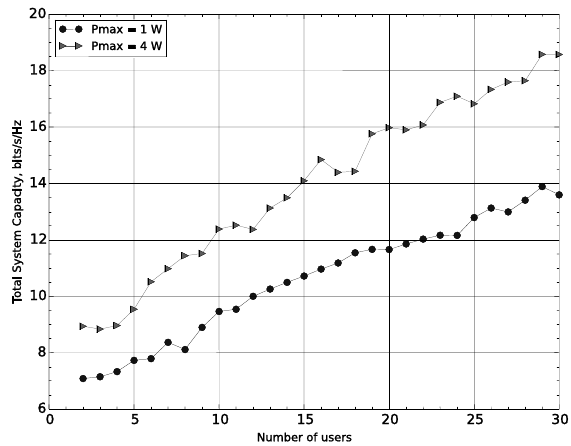
Fig. 2. Total system capacity with 30 users in the system with different allowed power